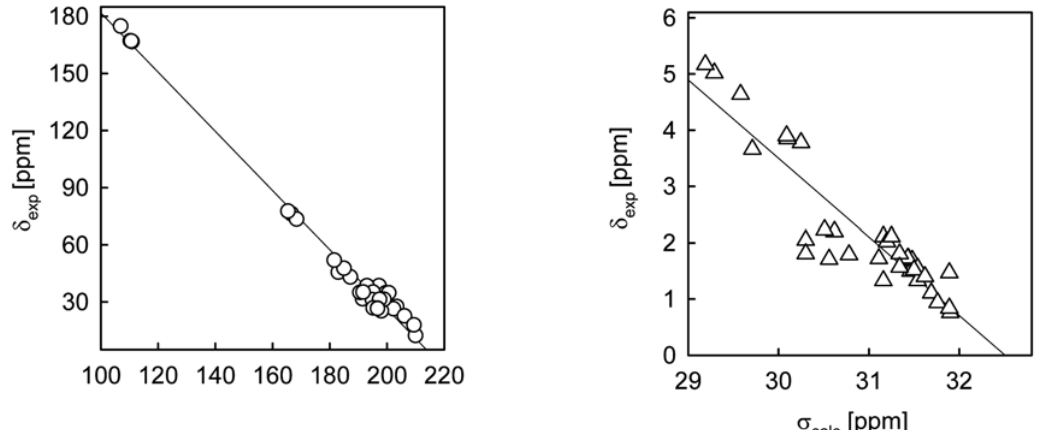
Figure 5. Plots of the experimental chemical shifts ( δ ) vs. the magnetic isotropic shielding constants ( σ ) from the GIAO/B3LYP/6-31G(d,p) ap- proach calculated for 10 in CDCl